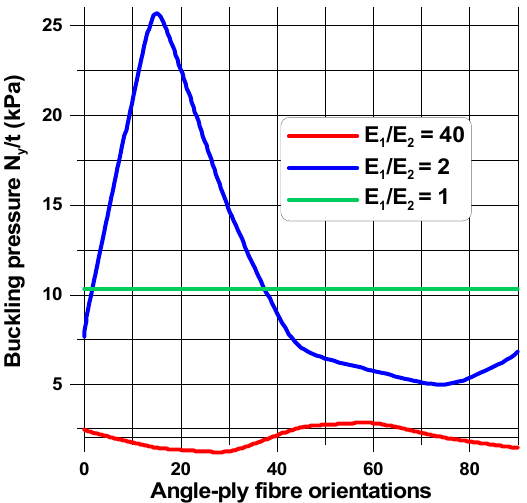
Figure 10. Distributions of buckling loads with fibre orientations ( θ ) and the orthotropic parameter, β = E 1 / E 2 , G 12 / E 1 = 0.015 for the square plate with the circular hole 2 b / L x = 0.4.